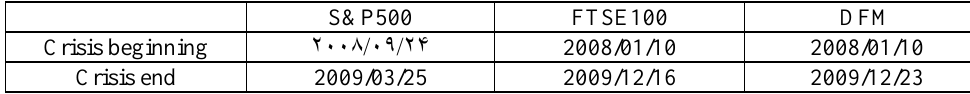
Table 4-2. Structural Breaking Test Results in ICSS